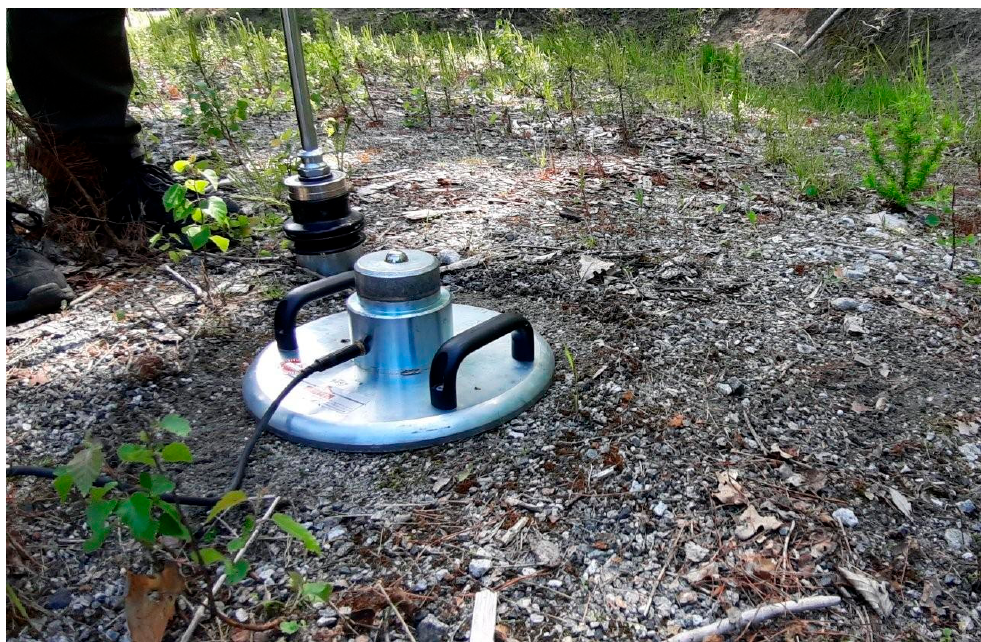
Figure 2. The bearing capacity testing with lightweight deflectometer on the experimental forest road section no. 2 in spring 2020, in the place where vegetation had been previously removed—“E” symbol in Table 2 (Photo: S. M. Grajewski).